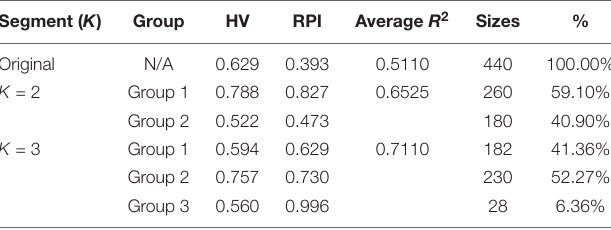
TABLE 9 | PLS-POS results for segment retention criteria.